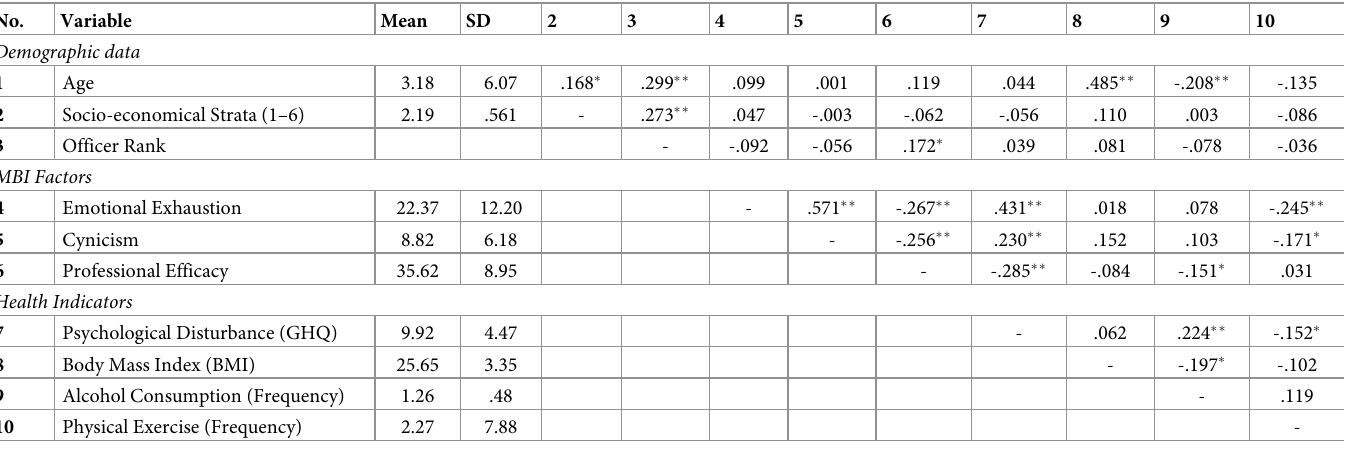
Table 1. Descriptive results and pearson’s bivariate correlations between study